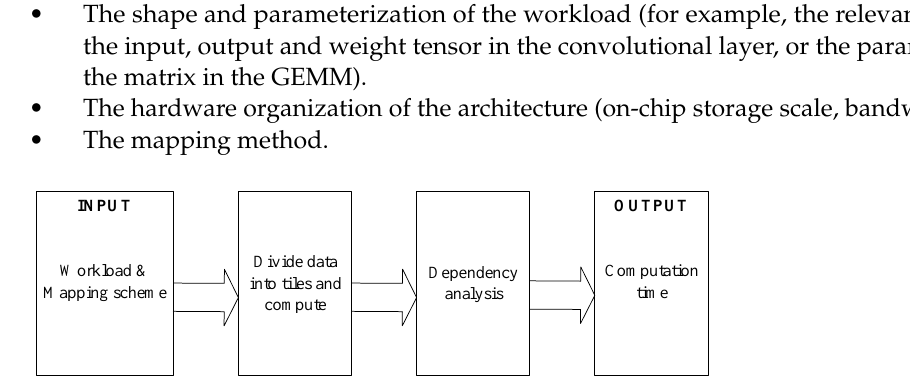
Figure 3. The basic workflow of